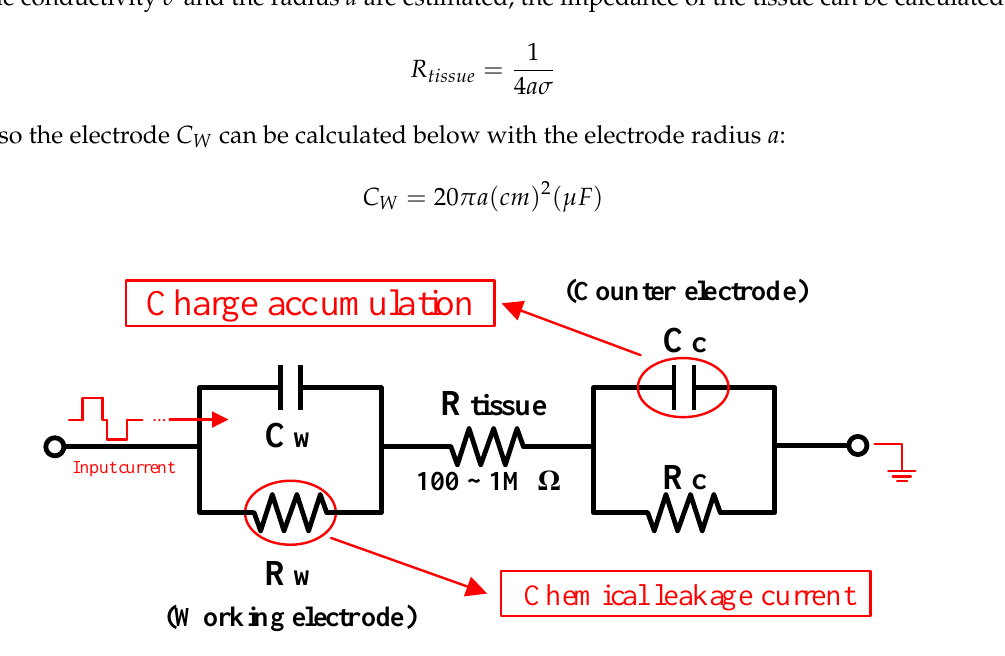
Figure 5. Electrode-electrolyte model. C W , R W represent the equivalent impedance of the working electrode, which is denoted as the anode. C C , R C represent the equivalent impedance of the counter electrode, denoted as the